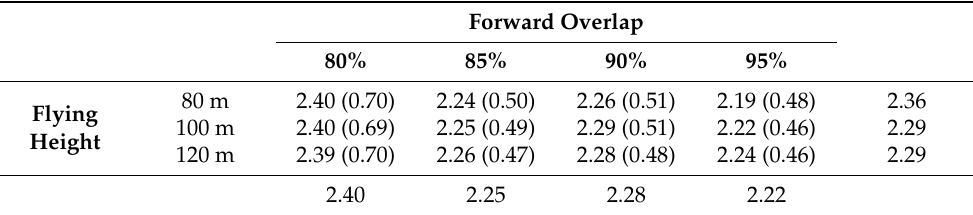
Table 5. RMSE TCH across the levels of flying height and forward overlap in meters. Values are the mean and standard deviation (in parentheses) for the four sites. Marginal values are row and column averages.